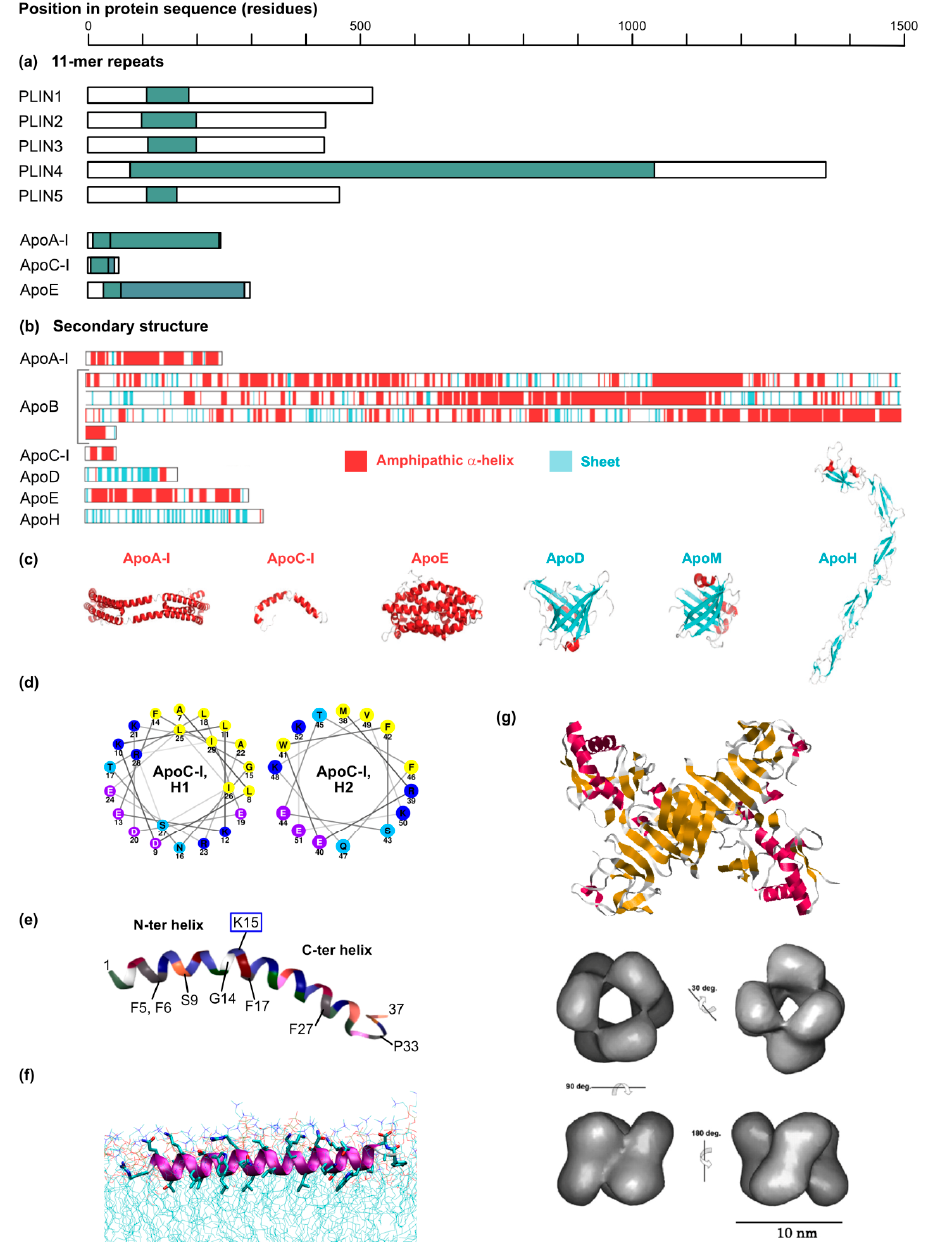
Figure 5. Striking sequence and structural features of apolipoproteins and apolipoprotein mimics. ( a ) Like the perilipins, apolipoproteins contain 11-mer repeats (teal-colored boxes) that have the propensity to fold as amphipathic α -helices. ApoA-I, C-I and E are shown as examples. For the apolipoproteins (the mature proteins are depicted), the two colored boxed correspond to 11-mer repeats found in exons 3 and 4, respectively. In some cases, the 11-mer repeats are organized themselves into larger motifs: 33-mer (3 × 11-mer) repeats for PLIN4 [154], 22-mer repeats for most 11-mers found in exon 4 of the apolipoproteins [155]. Note that PLIN2 is also called ADRP, and PLIN3 corresponds to TIP47. The coordinates of the 11-mer-containing domains have been extracted from Copic A. et al. [154] for the PLIN proteins and from Luo C.C. et al. [155] for the apolipoproteins.